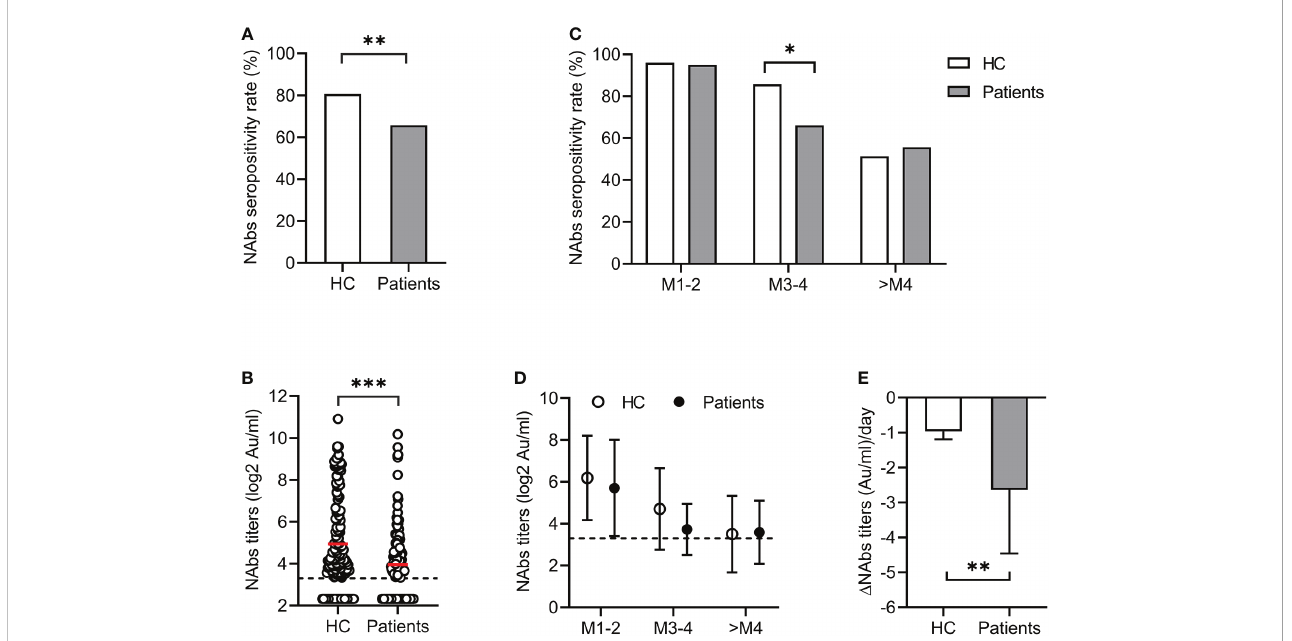
FIGURE 1 Antibody responses after COVID-19 vaccination. The seropositivity (A) and titers (B) of NAbs in patients with liver dysfunction and healthy controls (HC). Dynamic changes of NAbs seropositivity (C) and titers (D) over time during longitudinal follow-up. (E) Comparison of decline rate of NAbs titers in patients with liver dysfunction and HC groups. *<0.05; **<0.01; ***<0.001. AU, arbitrary units; COVID-19, coronavirus disease 2019; HC, healthy controls; NAbs, neutralizing